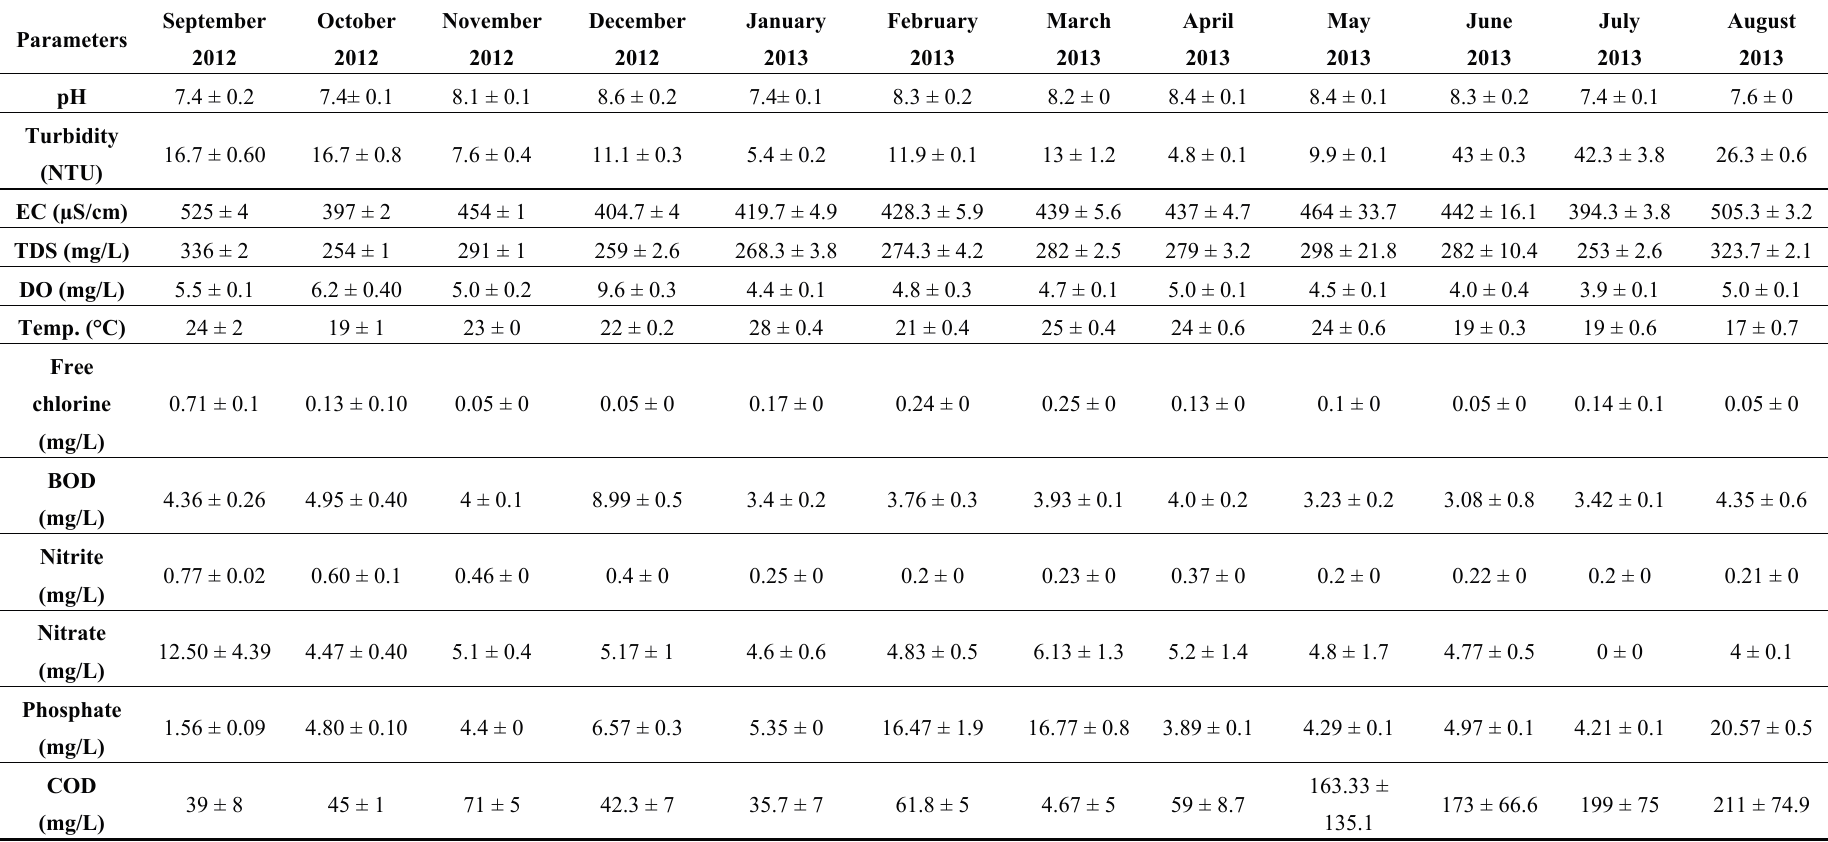
Table 2. The average means of the measured physiochemical parameters for the